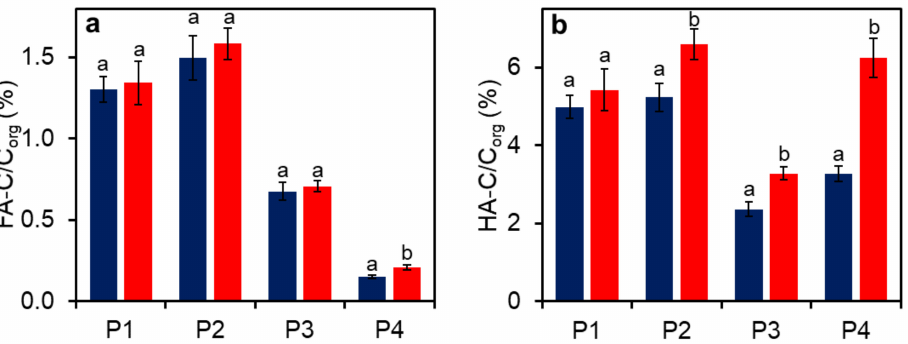
Figure 1. Concentration of FA-C ( a ) and HA-C ( b ) as a percentage of C org in fresh (blue) and stored